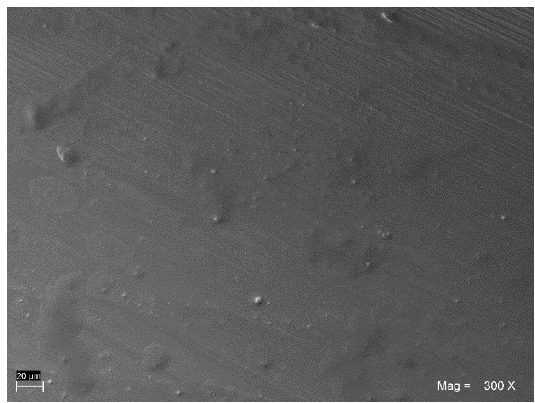
Figure 5. Group 3. After 50 steam autoclave cycles, no areas of corrosion were observed.